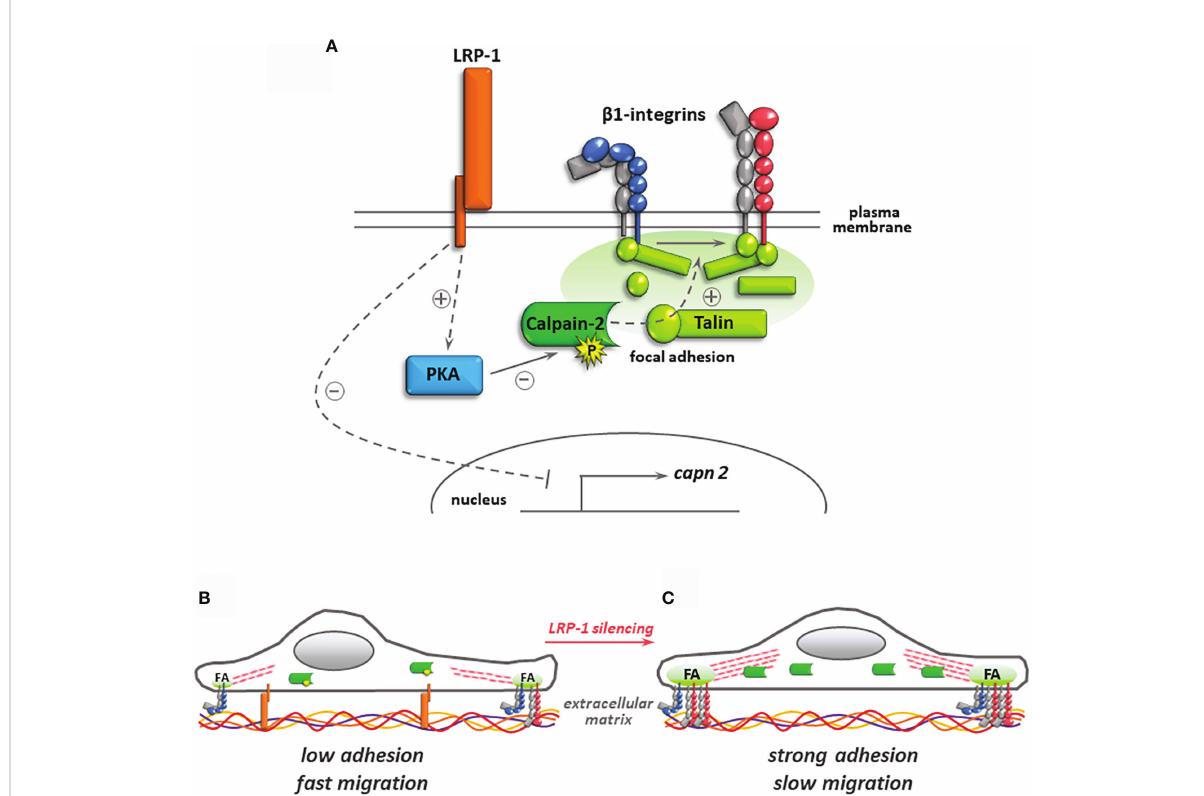
FIGURE 8 Regulation of calpain activity by LRP-1 and its consequences for thyroid carcinoma cell adhesion. In the presence of LRP-1, low transcriptional expression and PKA-mediated phosphorylation of calpain-2 controls talin-rich focal adhesion complexes dynamics and surface expression of inactive (blue) and active (red) forms of b 1 integrins (A) . The resulting intermediate adhesive state contribute to the invasive potential of polarized tumor cells (B) . Under LRP-1 silencing, gene induction of calpain-2 and decrease of its PKA-dependent phosphorylation result in strong calpain activity. Subsequently, tumor cells exhibit an overspread phenotype explained by surface accumulation of b 1 integrin and focal adhesion (FA) stabilization leading to impaired invasive capacities (C)